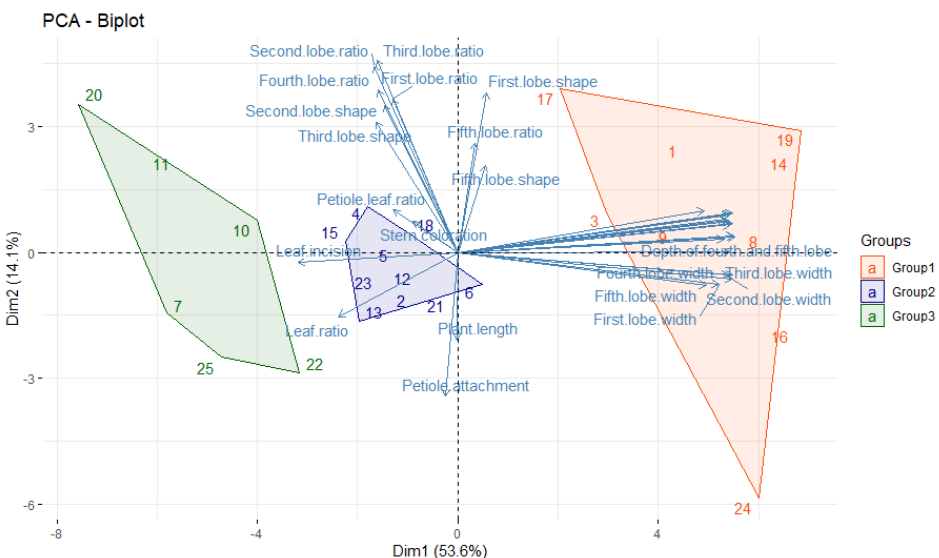
Figure 4. Principal Component Analysis (PCA) of 25 Ricinus communis samples based on 27 quanti- tative morphometric characters with the correlation between different variables and the first two components. Length of the variable arrow representing the importance of different variables where longer arrows contribute the most to the discrimination of the three groups. Table 3. Principal component analysis (PCA) with their Eigenvalues and variance for Ricinus communis based on 27 quantitative morphometric traits.